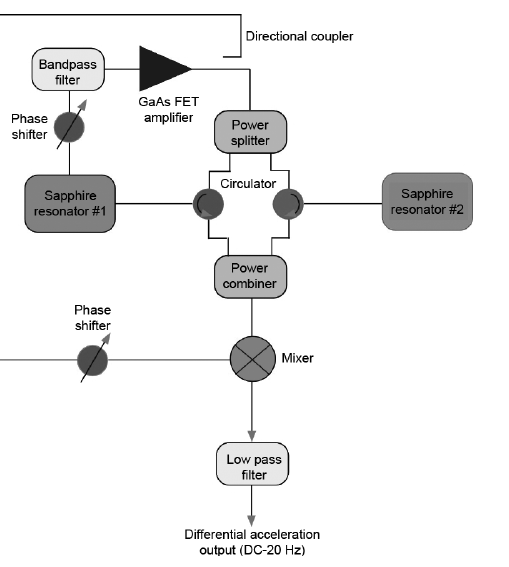
Fig. 7. Schematic of the interferometric microwave readout system. One resonator is used as the refer- ence cavity for a X -band loop-oscillator. Its output is used to interrogate the other dielectric resonator and the frequency difference is read by a double-bal- anced mixer.